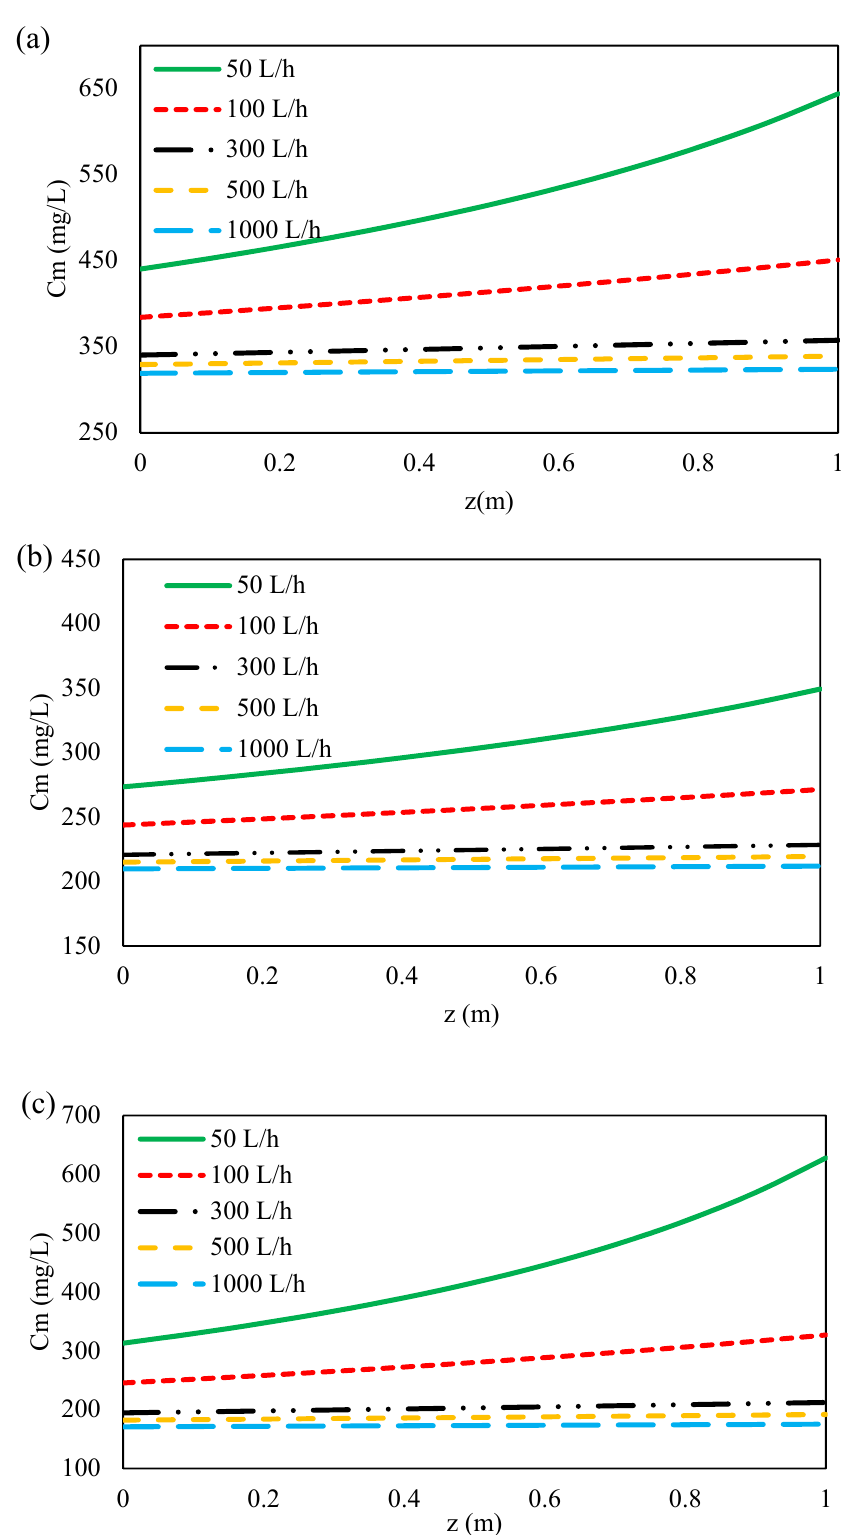
Figure 10. Feed concentration profile on membrane surface along the feed flow direction for ( a ) formate, ( b ) acetate, ( c ) sulfate at 70 bar inlet feed pressure and different feed flow rates.